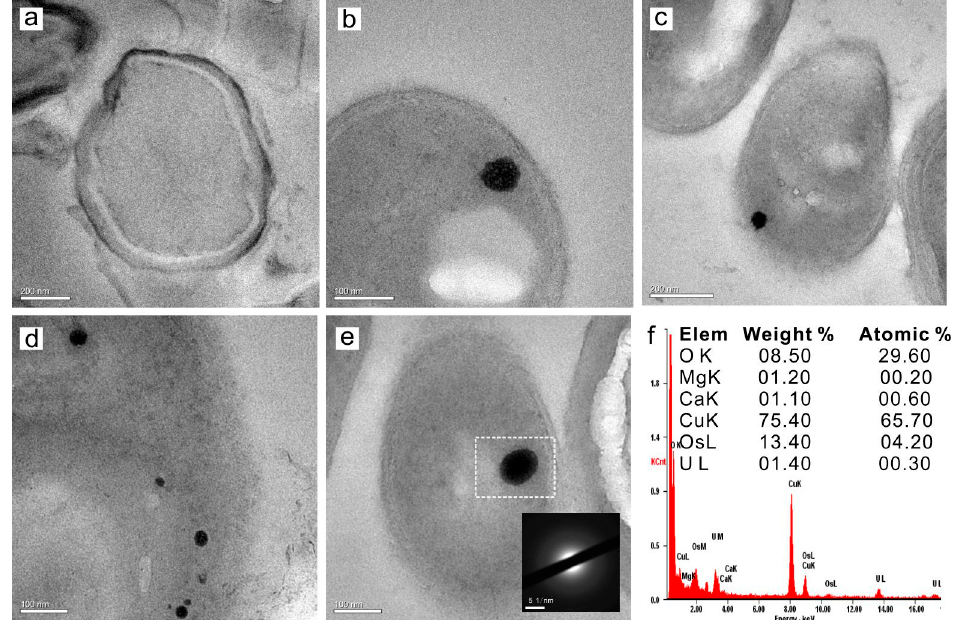
Figure 8. High resolution transmission electron microscope, selected area electron diffraction, and energy spectrum analyses of ultrathin slices of B. licheniformis SRB2. ( a ), SRB2 seed; ( b – e ), Mg / Ca molar ratios of 6, 8, 10, and 12, respectively; inset in ( e ), SAED image; ( f ), EDS analysis of intracellular inclusion.